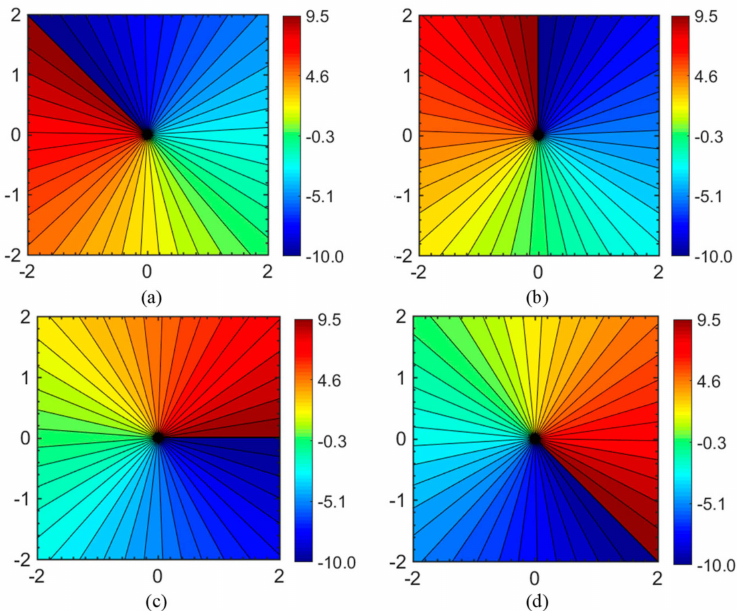
Figure 5. The branch cuts of the potential function of the vortex in Figure 4 rotated by various angles in clockwise direction: ( a ) Angle of 45 ◦ , ( b ) Angle of 90 ◦ , ( c ) Angle of 180 ◦ , and ( d ) Angle of 225 ◦ .